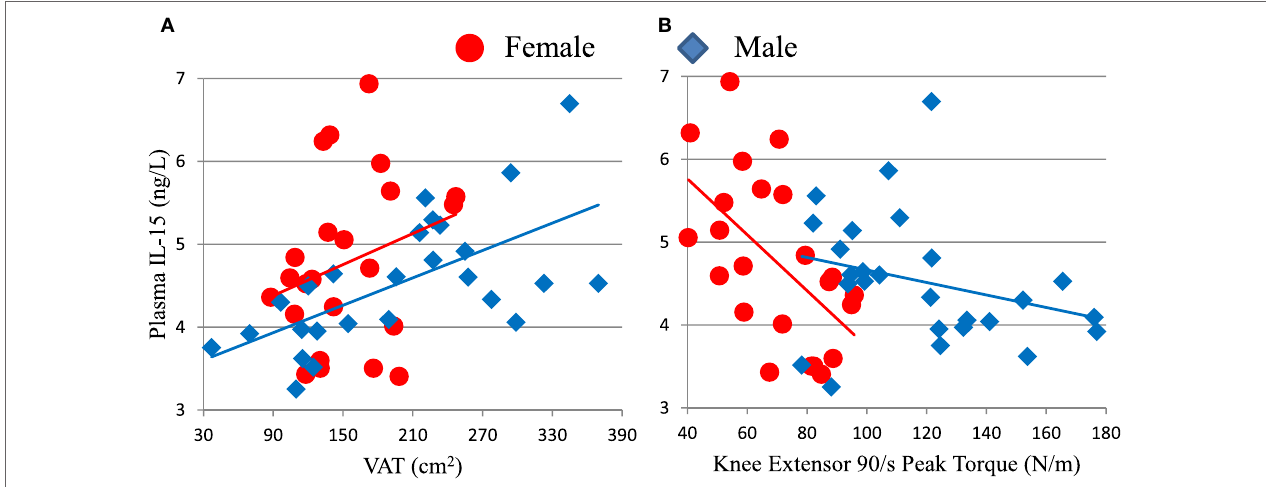
FigUre 5 | Plasma IL-15 level associates with visceral adipose tissue (VAT) (a) and inversely associates with knee extensor peak torque (B) in cohort D. Associations of IL-15 with VAT were significant in all subjects ( ρ = 0.442, p = 0.001) and in males ( ρ = 0.657, p < 0.001), but not in females tested separately. IL-15 inversely associated with strength in all subjects ( ρ = − 0.348, p = 0.014) and in females ( ρ = − 0.581, p = 0.004), but not in males considered separately. Cohort D is described in Table S1 in Supplementary